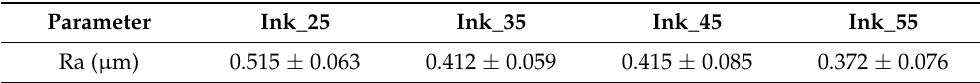
Table 2. Roughness data of the CuO-based